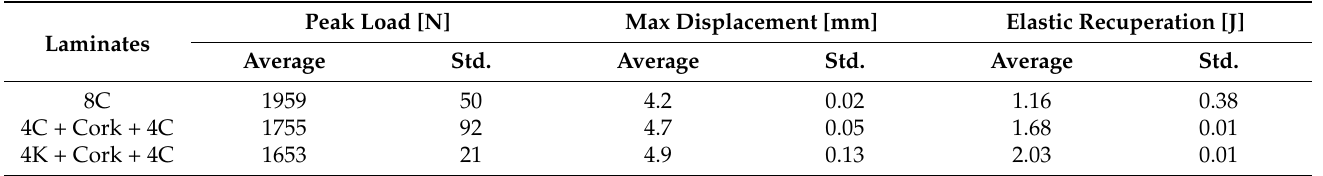
Max Displacement [mm] Elastic Recuperation [J]